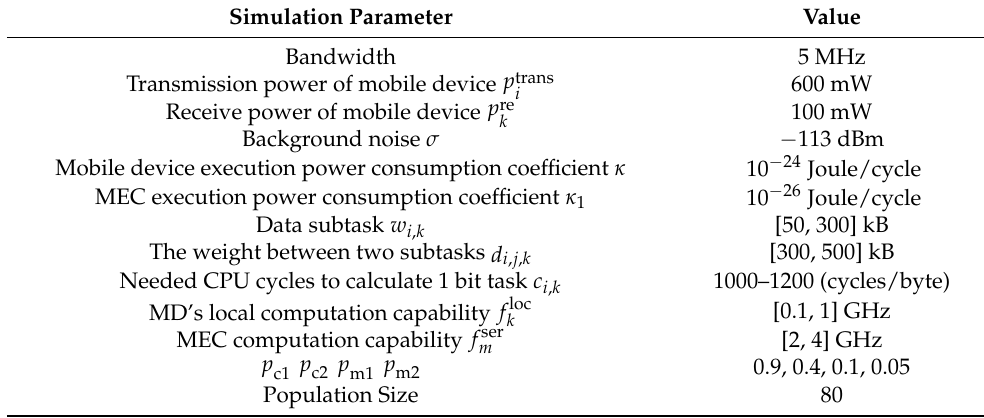
Table 1. Simulation parameter.